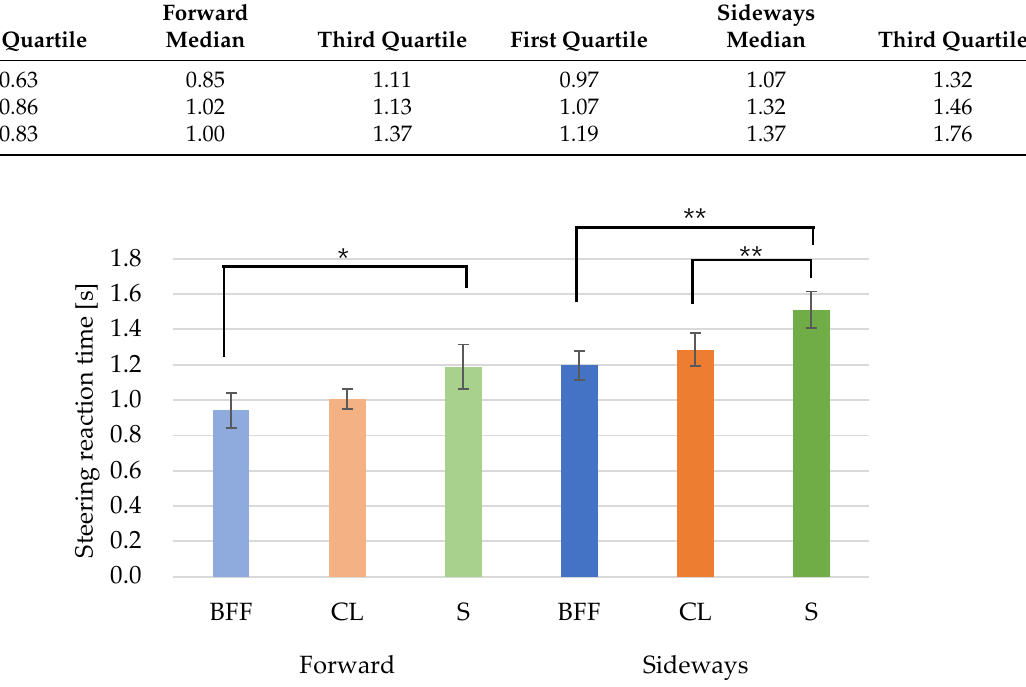
Figure 5. Foot posture comparisons of steering reaction time. ∗ p < 0.05/ ∗∗ p < 0.01.